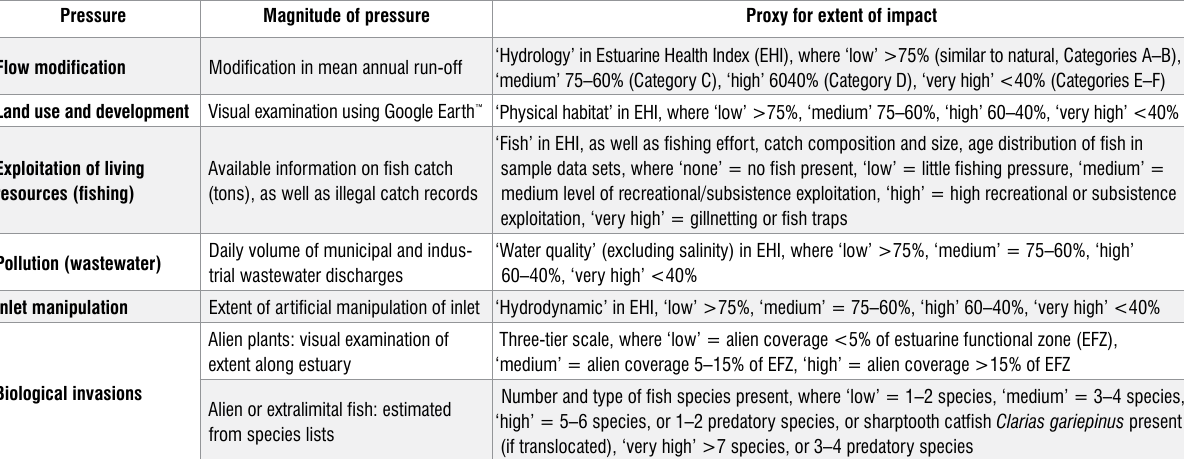
Indicators of magnitude and proxies for extent of impact of key pressures in estuaries (adapted from Van Niekerk et al. 32 ) Pressure Magnitude of pressure Proxy for extent of impact Flow modification Modification in mean annual